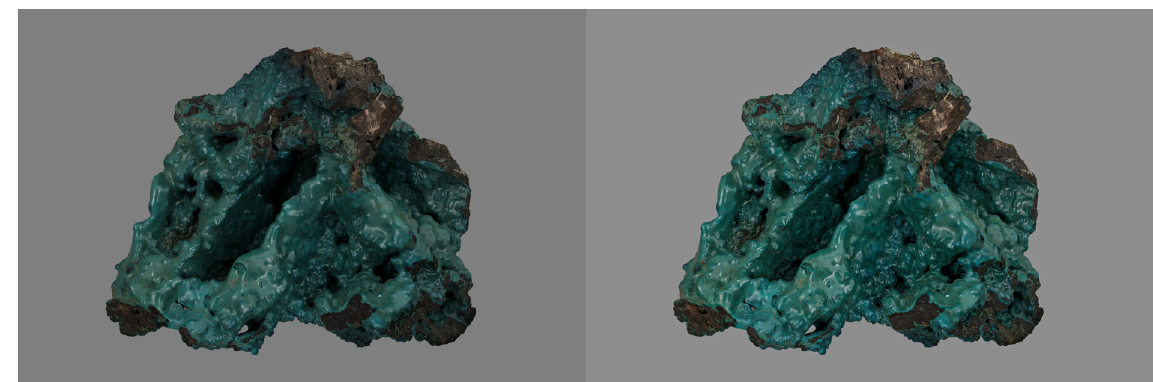
Fig. 5.2. Micro-contrast enhancement and relighting in DxO OpticsPro 11. The original image is on the left, the post-processed picture on the right. The dark area in the middle is now sufficiently exposed, without losing the look and feel of the